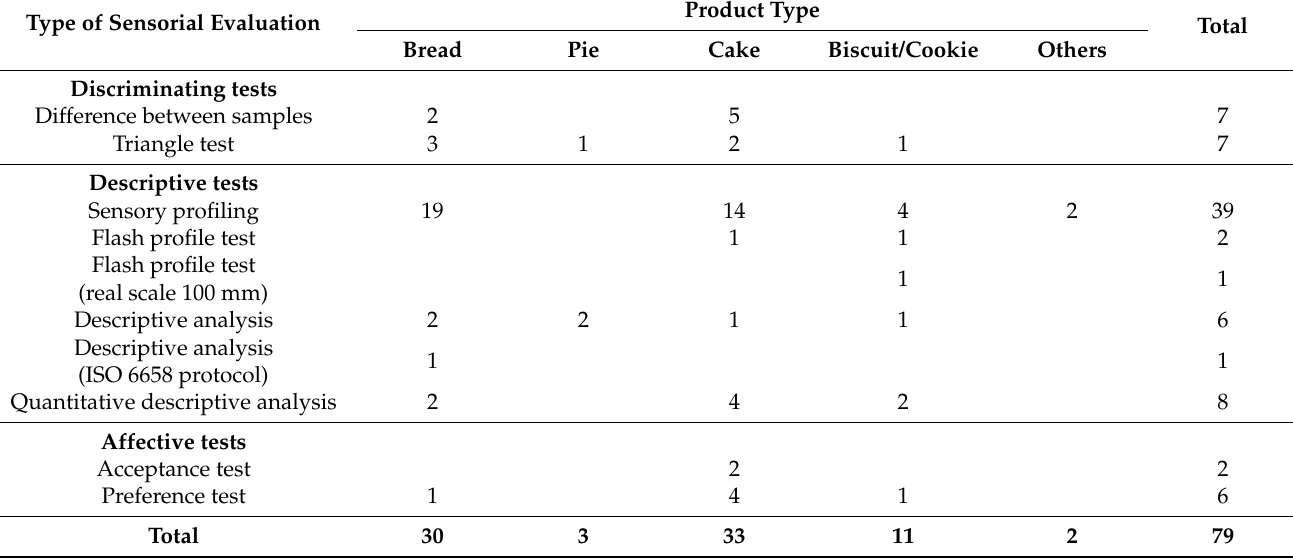
Table 5. Number of studies according to the method used for the sensorial evaluation of texture and product